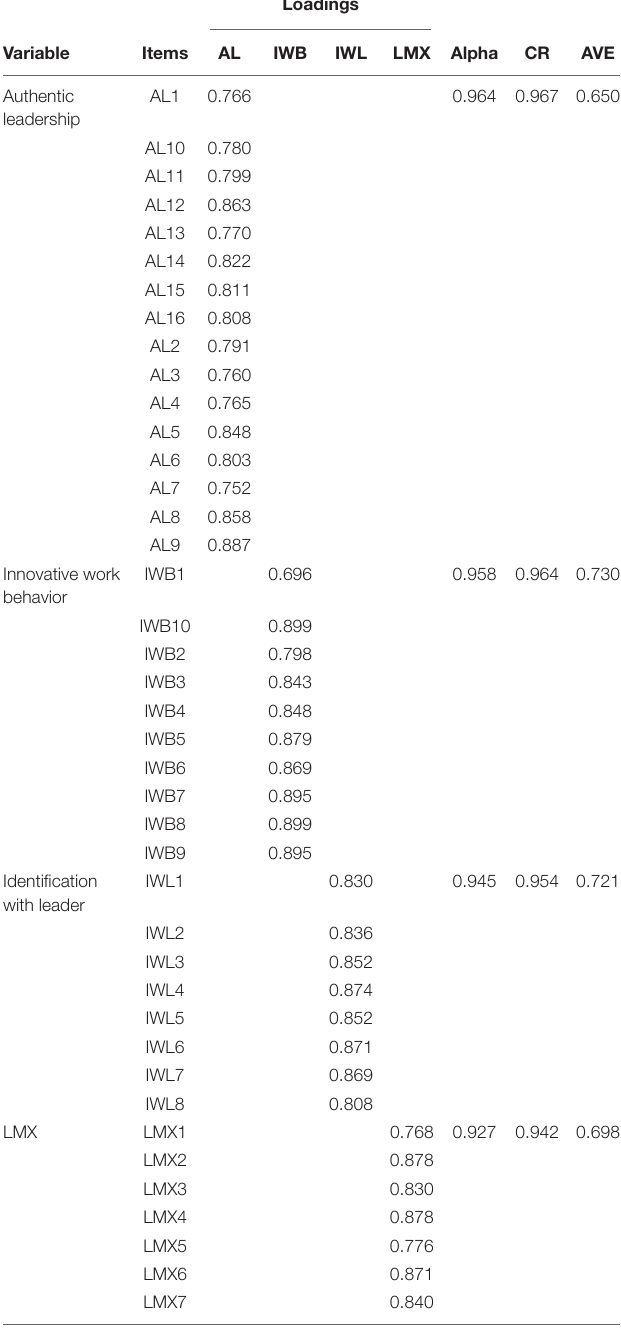
TABLE 2 | Reliability and